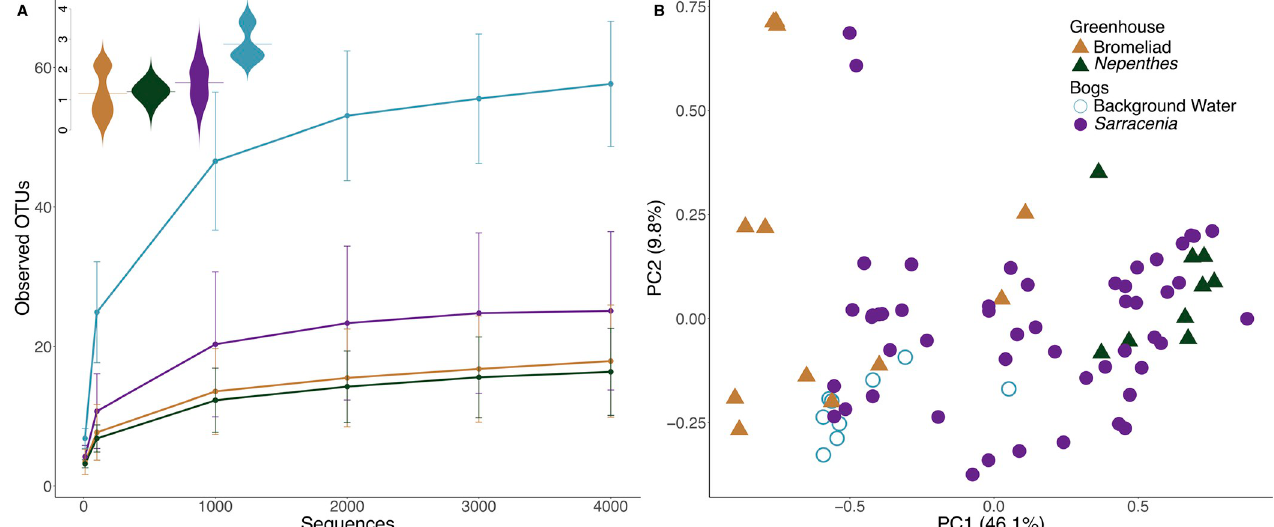
Fig 2. A . OTU richness (rarefaction plots, error bars are standard deviations) and Shannon diversity (inset beanplots) is highest in samples from the background community (light blue), followed by samples collected from Sarracenia (purple), bromeliads (brown), and Nepenthes (green). B . Principal Coordinate Analysis based on weighted UNIFRAC demonstrates differentiation of communities by host plant, with tremendous heterogeneity among communities in field-collections from Sarracenia (purple dots) and among greenhouse bromeliads (brown triangles; all from the same room in the Lyman Conservatory). Details on site and OTUs can be found in S1 and S2